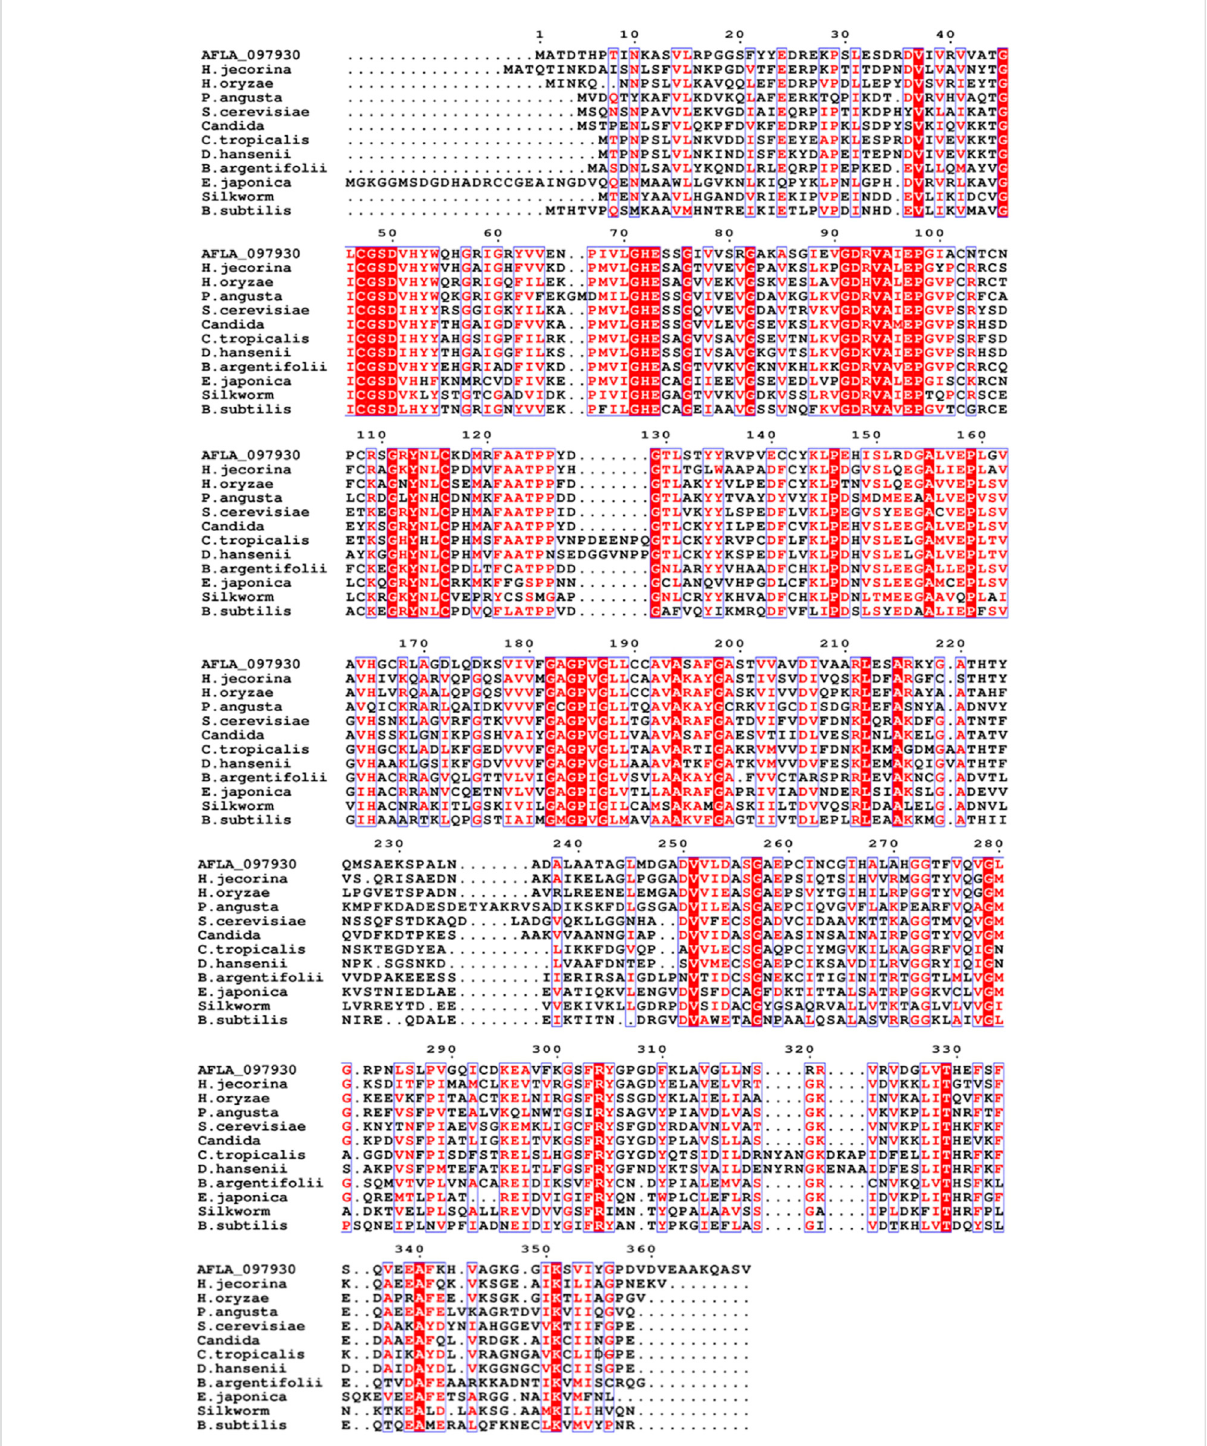
FIGURE 1 Multiple sequence alignment of A. fl avus XDH with selected medium-chain reductase/dehydrogenases (MDRs). AFLA_097930, Aspergillus fl avus XDH; H. jecorina , Hypocrea jecorina MDR; H. oryzaea , Hirschmanniella oryzae MDR; P. angusta , Pichia angusta MDR; S. cerevisiae , Saccharomyces cerevisiae MDR; Candida, Candida sp. MDR; C. tropicalis , Candida tropicalis MDR; D. hansenii , Debaryomyces hansenii MDR; B. argentifolii , Bemisia argentifolii MDR; E. japonica , Eriobotrya japonica MDR; Silkworm, Bombyx mori MDR; B. subtilis , Bacillus subtilis MDR. The red column shows conserved residues in the alignment, the dot (.) represents the gap, and the black sequences show non-conserved